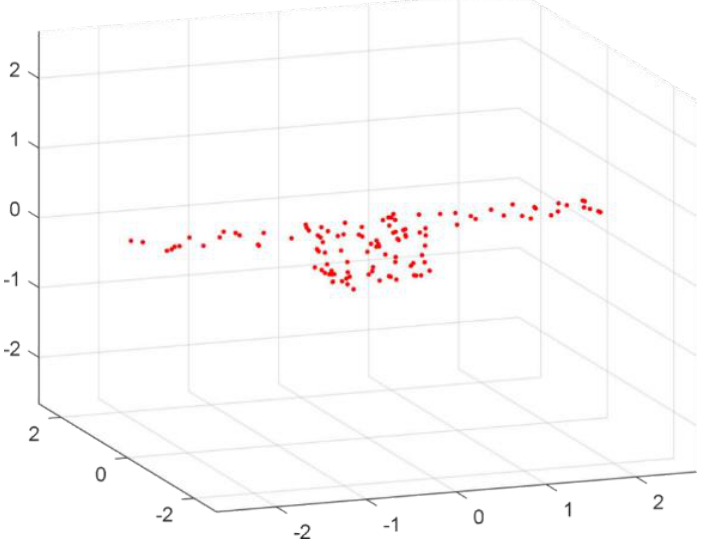
Figure 18. The positions 120 pairs of feature points in the target spacecraft coordinate system.